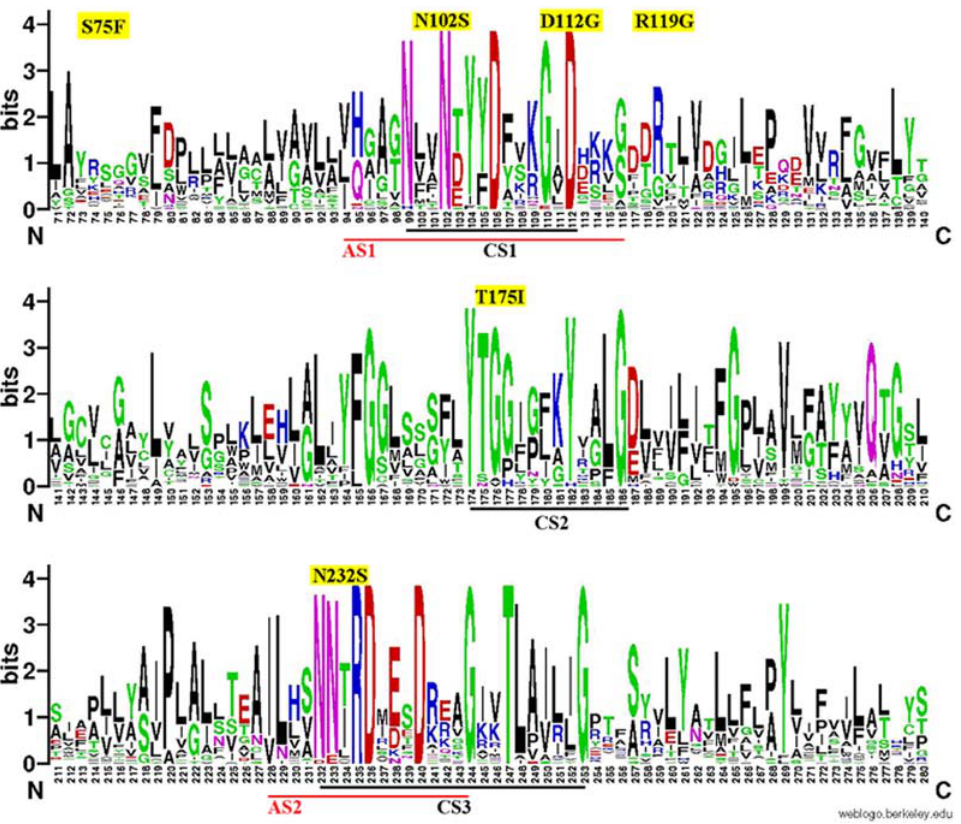
Figure 5. Conserved amino acid residues in three regions of UBIAD1 containing familial mutations (CS1, CS2, CS3). Also shown are two regions aligning with putative bacterial UbiA active sites (AS1, AS2), which are overlapped with CS1 and CS3, respectively. Familial mutations plus the control variant detected in this study are highlighted in yellow above each consensus plot. The sequence logo was generated with the multiple sequence alignment of distant orthologs selected from Eukaryota, Bacteria, and Archaea. The pairwise alignment of human UBIAD1 and E.coli UbiA peptide sequences aligned by ClustalW was used to annotate the regions of putative active sites.